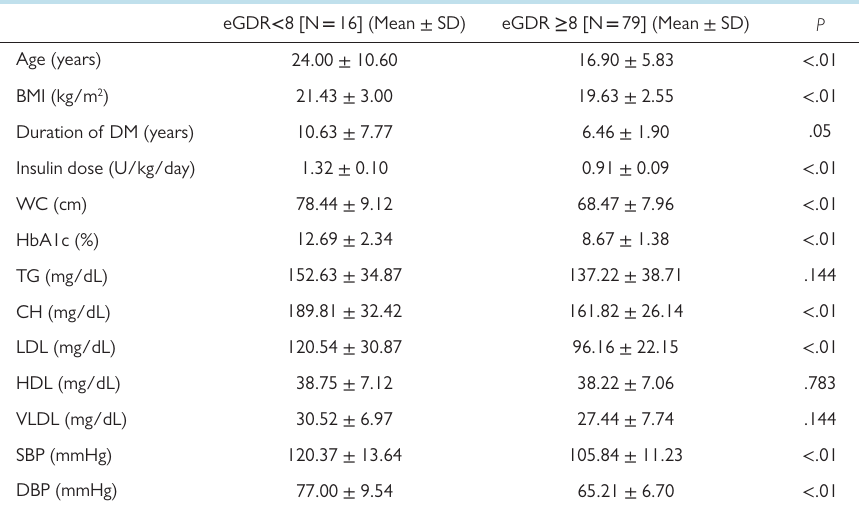
Table 2. Comparison of Various Characteristics of Patients with eGDR < 8 and eGDR ≥